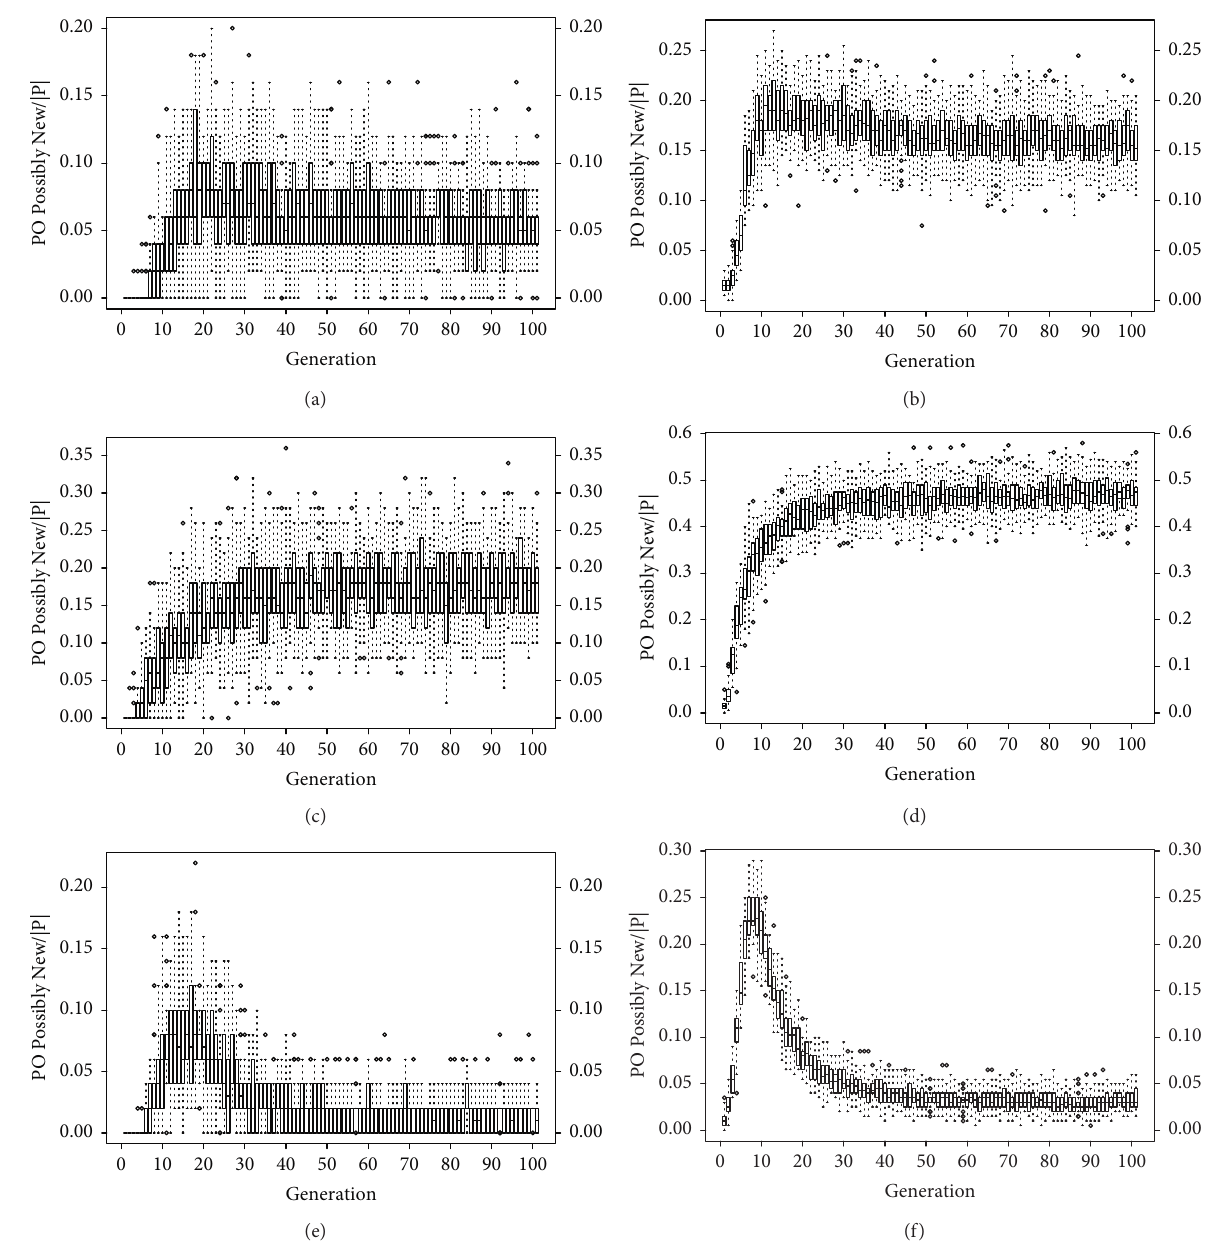
Figure 4: Pareto optimal solutions in the population that are new respect to the previous generation. Population sizes 50 and 200 for 3 and 6 objectives, respectively. Algorithms A ϵ S ϵ H, MOEA/D, and IBEA | P | � 50, M � 3; (d) MOEA/D, | P | � 200, M � 6; (e) IBEA I